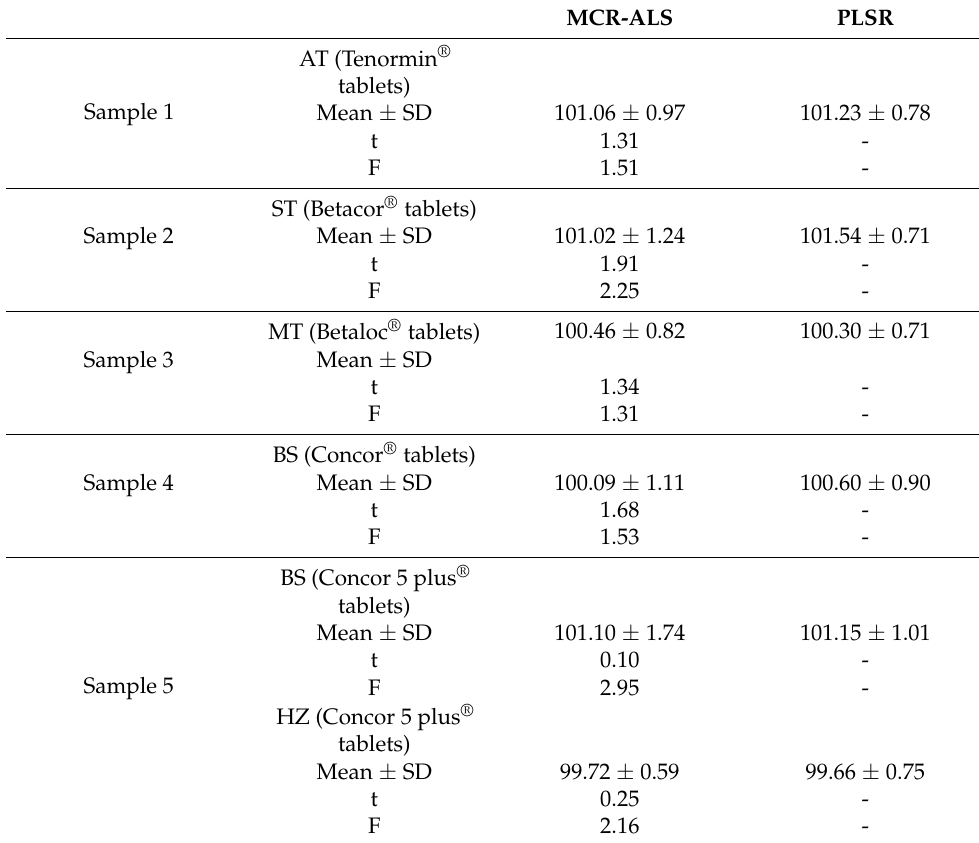
Table 3. Determination of the target analytes in commercial dosage forms using the proposed